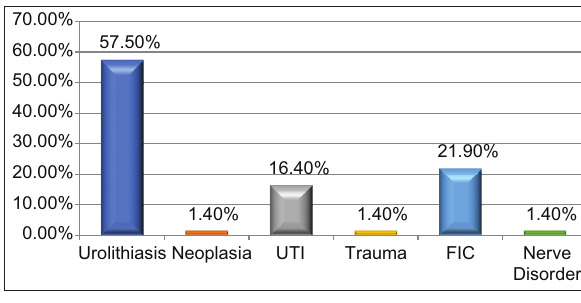
Figure-1: Diagnosis of feline lower urinary tract disease causes in cats in the Veterinary Hospital/animal clinic in Sleman Regency